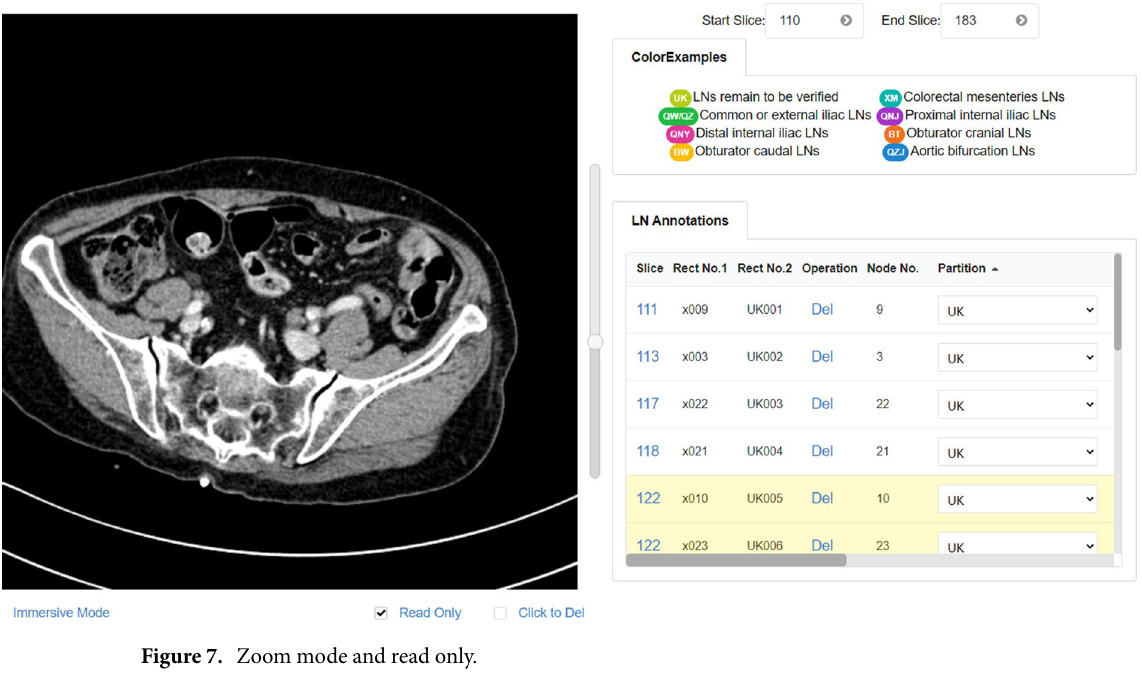
Figure 7. Zoom mode and read